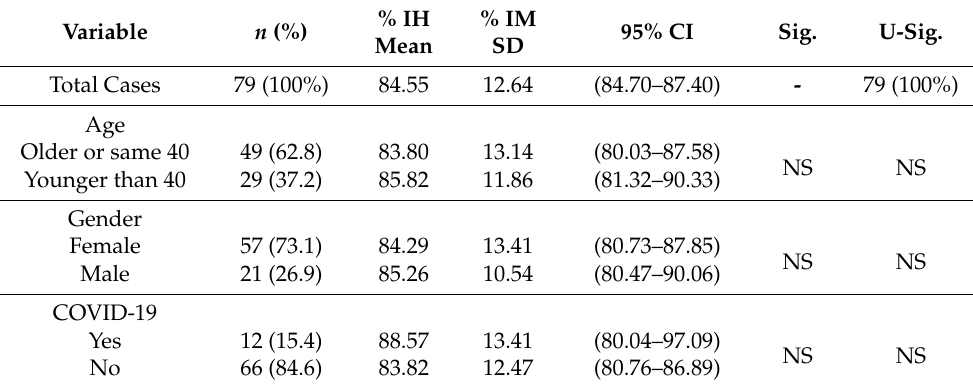
Table 2. Percentage of inhibition (% IH) according to age, sex, and history of COVID-19 infection in the group of